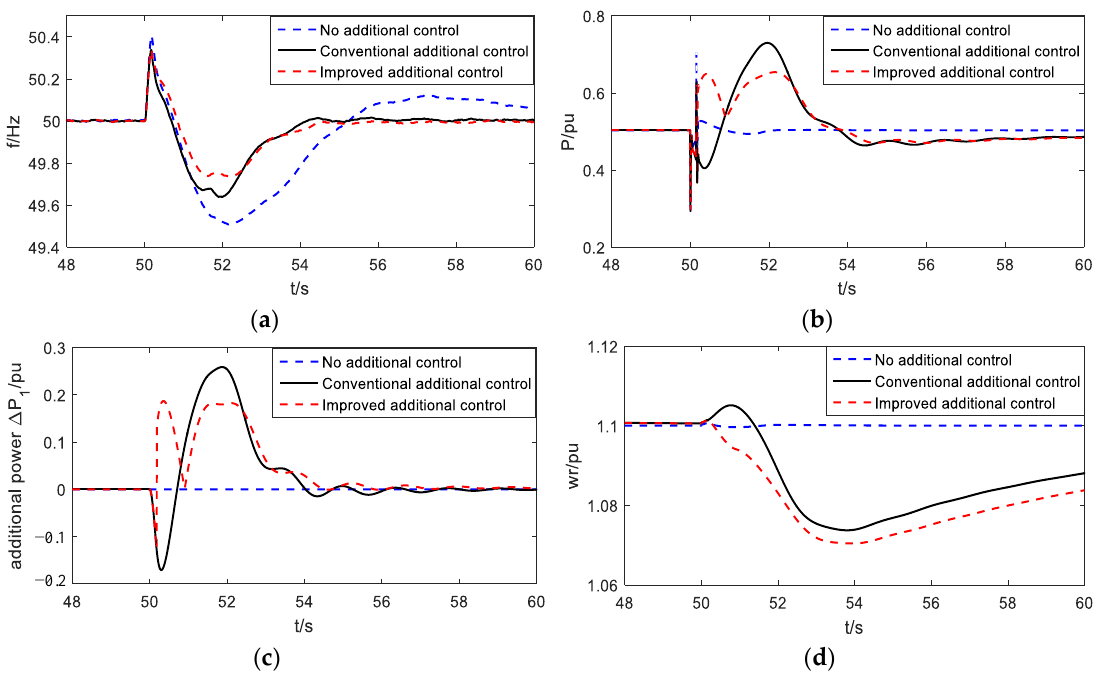
Figure 11. Change of parameters under a short-circuit fault by three different control methods in the wind speed of 11 m/s ( a ) System frequency; ( b ) Output active power of DFIGs; ( c ) Additional power of DFIGs; ( d ) Rotational speed of DFIGs.